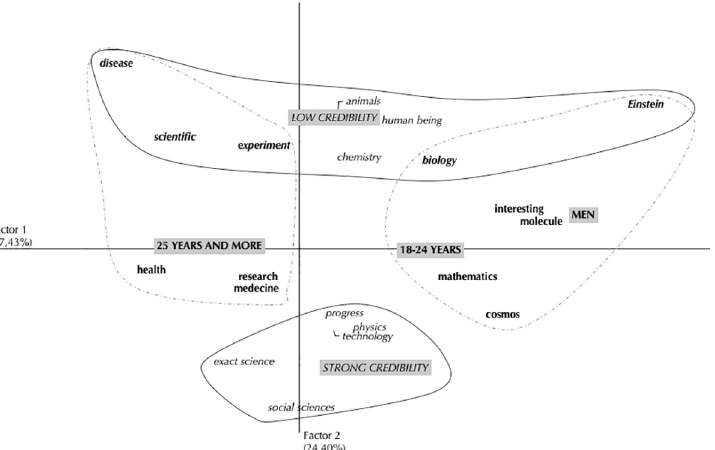
Fig 1. Results of the factorial analysis of correspondences related to science-related evocations. Grayed frames refer to the independent variables. “Independent variables” contribute to the formation of Factor 1; “Independent variables” refers to the independent variables which contribute to the formation of Factor 2. “Observations” refers to the observations which contribute to the formation of Factor 1; “Observations” refers to the observations which contribute to the formation of Factor 2; “Observations” refers to the observations which contribute to the formation of both Factors 1 and 2.